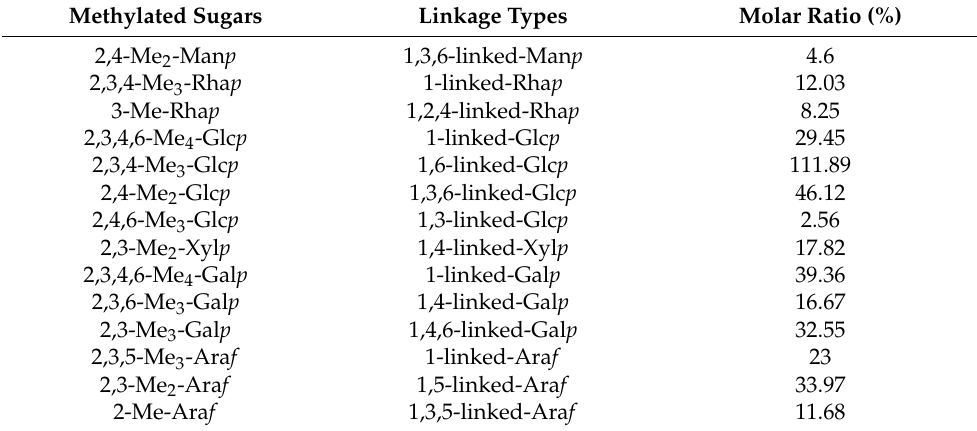
Table 1. Methylation analysis results of Pan.